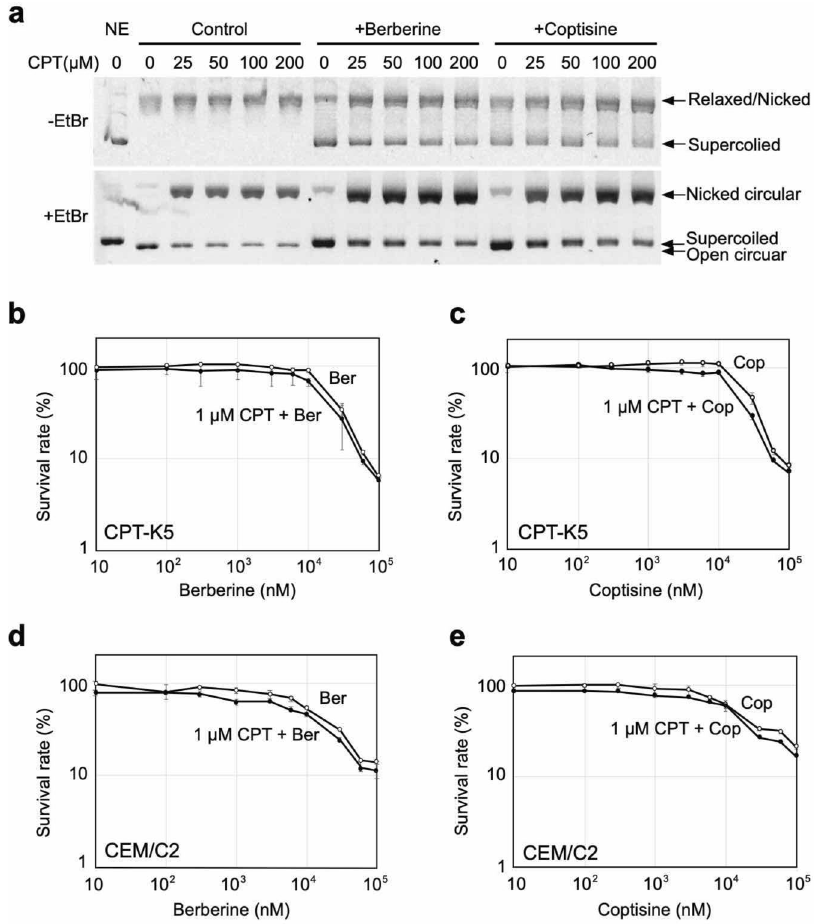
Figure 9. Effect of treatment with CPT combined with berberine and coptisine. ( a ) Effect of treatment with CPT combined with berberine and coptisine on the relaxation assay in vitro. ( b-e ) Effect of treatment with CPT combined with berberine and coptisine on the survival of CPT-resistant cell lines, as determined through the MTT assay. ( b,c ) Effect of treatment with CPT combined with berberine ( b ) and coptisine ( c ) on the survival of the CPT-K5 cell line, as determined through the MTT assay. ( d,e ) Effect of treatment with CPT combined with berberine ( d ) and coptisine ( e ) on the survival of CEM/C2 cells, as determined through the MTT